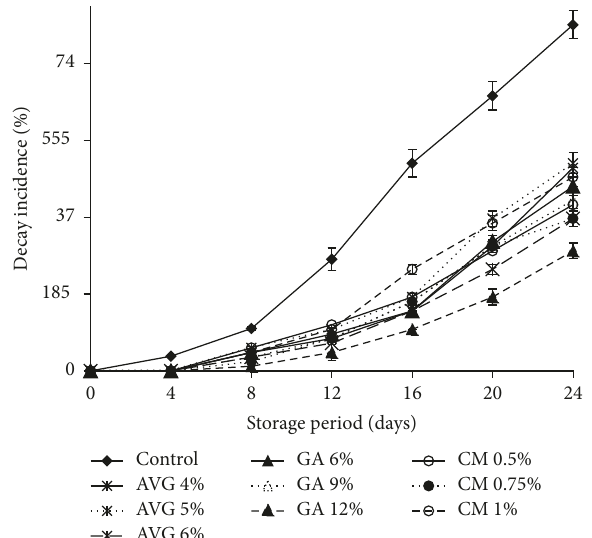
Figure 4: Effect of Aloe vera gel, gum arabic, and cinnamon oil coatings on the decay incidence in bell pepper during cold storage.